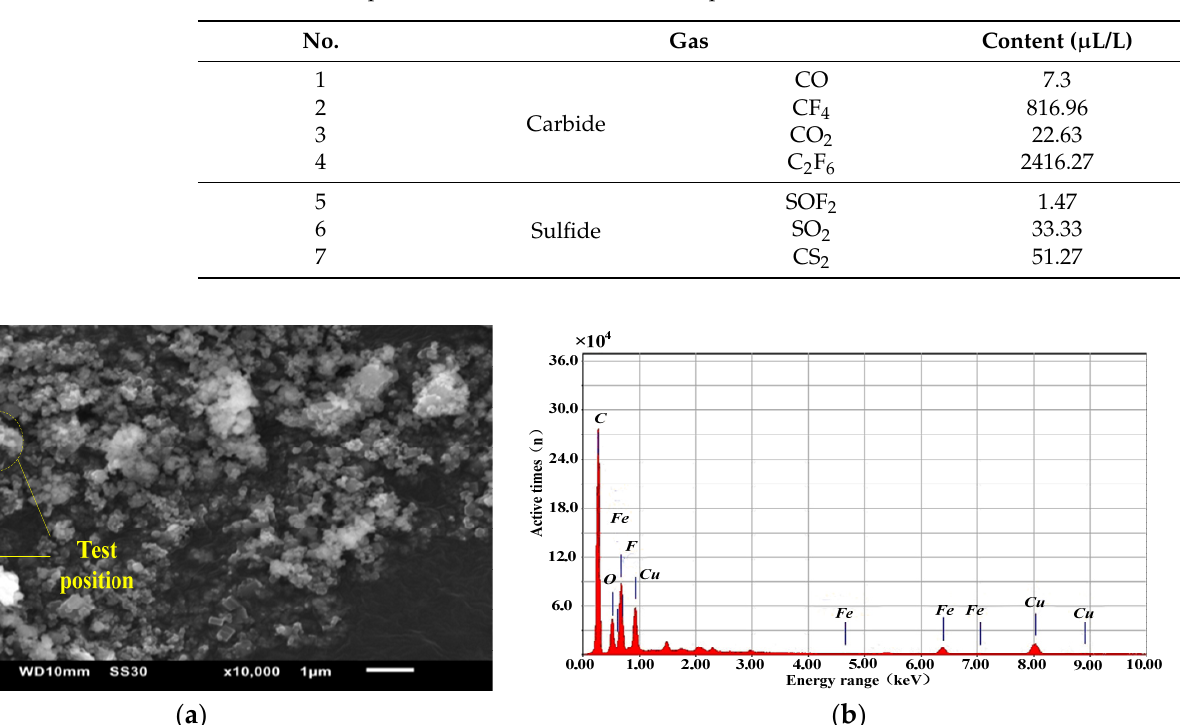
Table 2. Gas composition of test circuit breaker samples.